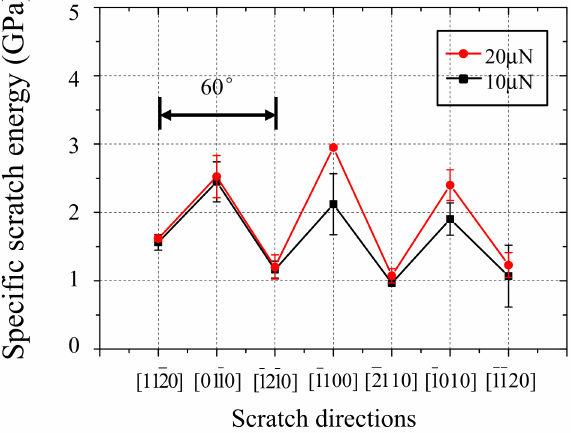
Figure 7. The relationship between scratch direction and specific scratch